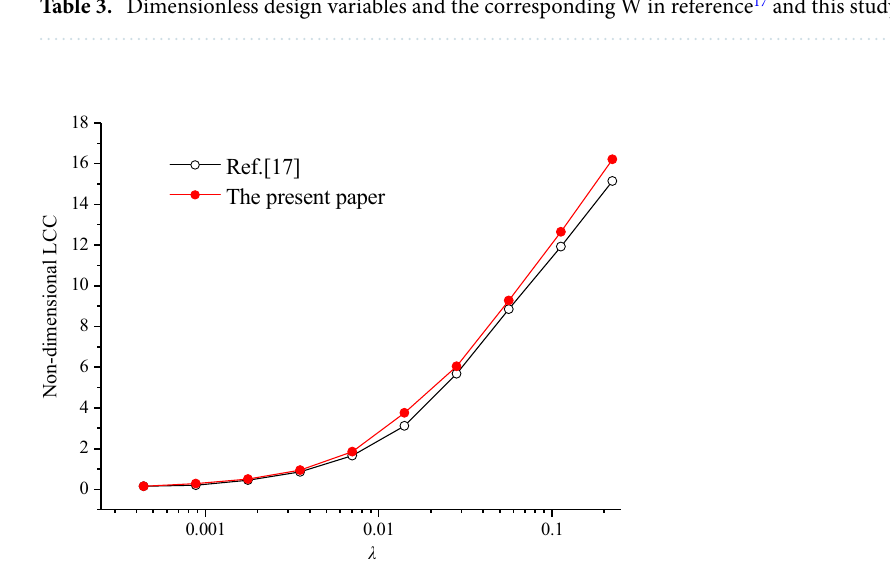
Figure 3. Comparison of the LCCs of optimum directional shapes between this study and reference 17